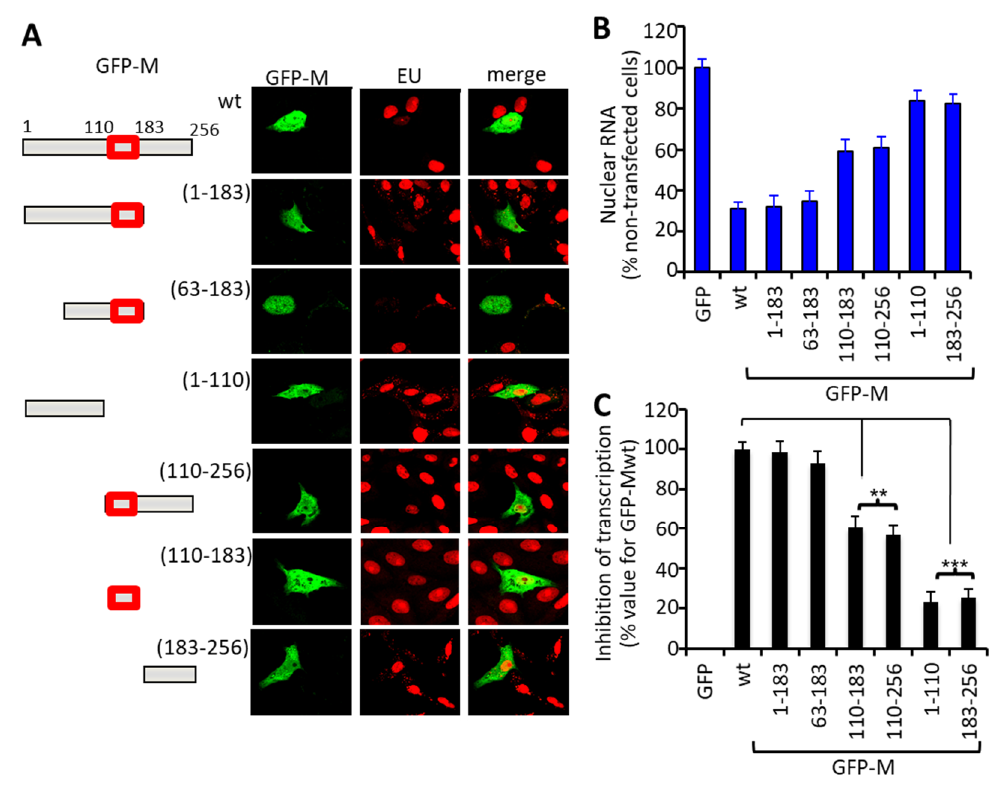
Figure 2. The central nucleotide binding region of RSV M is sufficient to effect transcriptional inhibition in living cells. ( A ) Schematic representations of the GFP-M fusion constructs used (left). Numbers refer to the M amino acid sequence, with the central domain, including the RNA binding region and nuclear localization signal (NLS), shown as a red box. Representative CLSM images of Vero cells expressing GFP-Mwt or truncated derivatives thereof (right) treated with EU, fixed, permeabilized, and stained for de novo synthesized RNA as per the legend to Figure 1. ( B ) Quantitative analysis for inhibition of de novo RNA synthesis ( n = 15) as per the legend to Figure 1. ( C ) Results from ( B ) are expressed in terms of percent inhibition of transcription relative to that effected by GFP-Mwt. Significant differences are indicated, ** p < 0.01, *** p < 0.001.